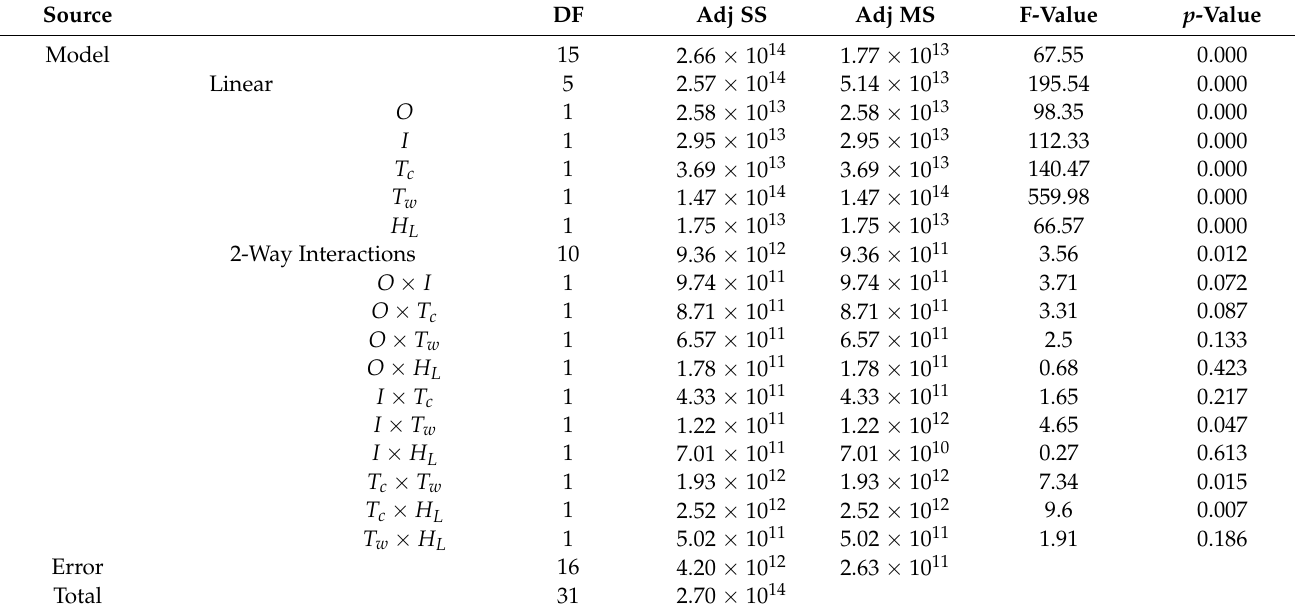
Table 6. ANOVA of the experimental set.